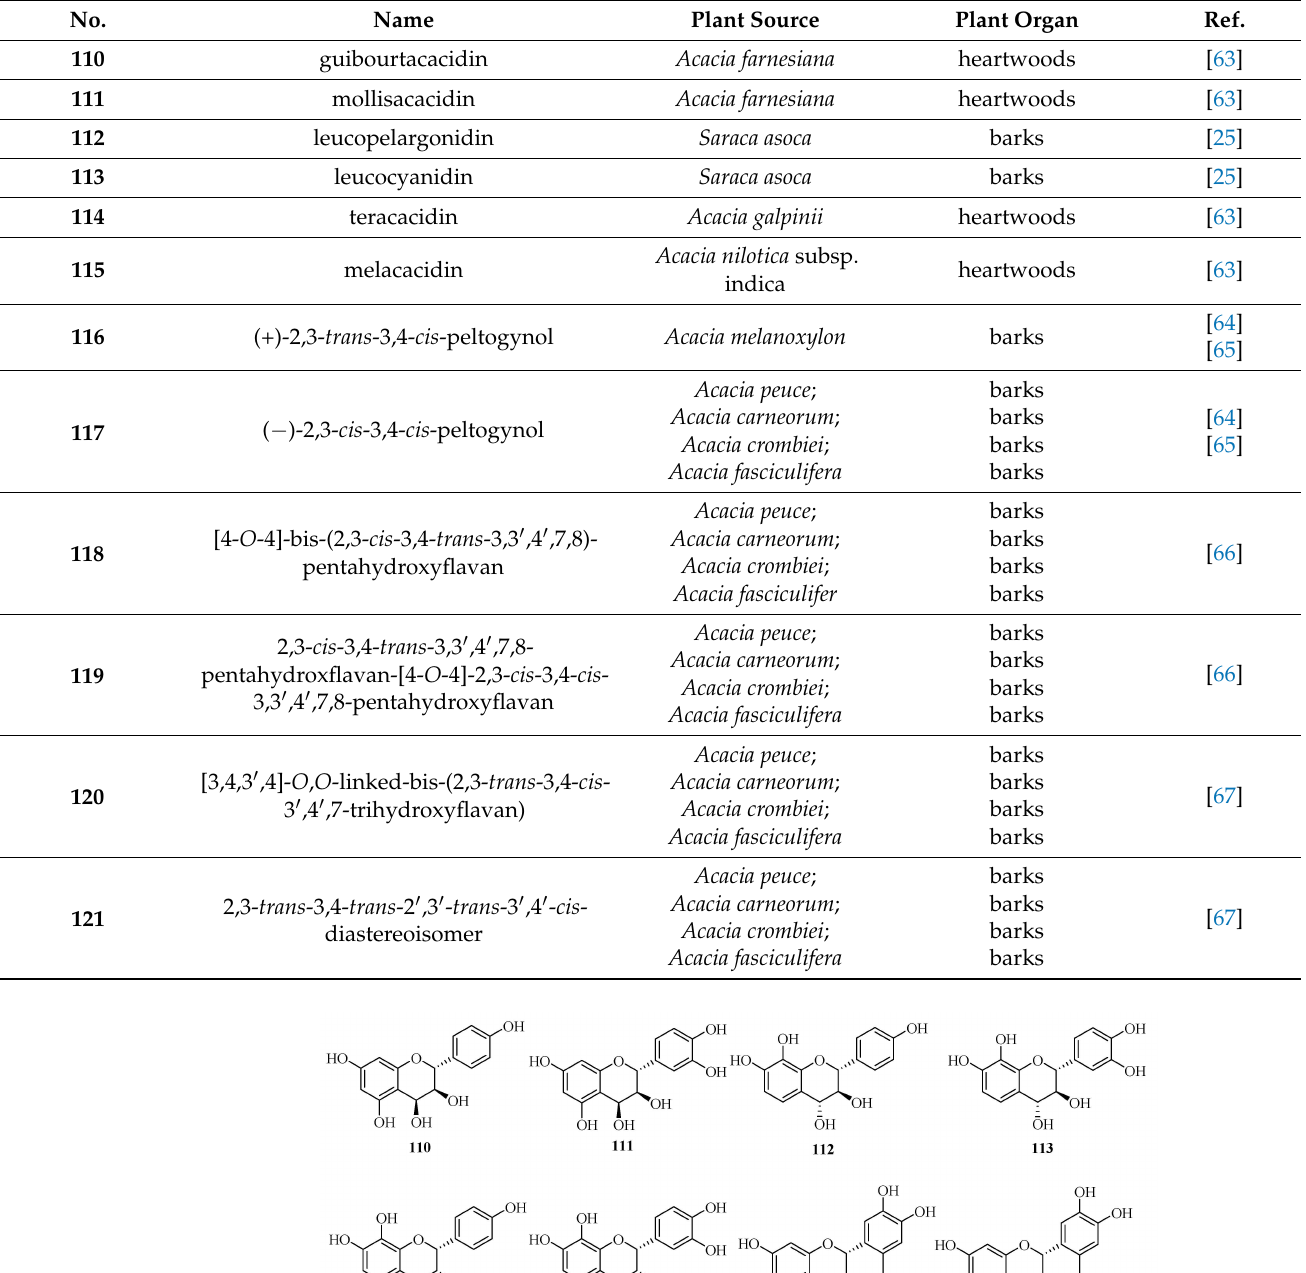
Table 4. The numbers, plant sources and corresponding organs of flavan-3,4-ols.